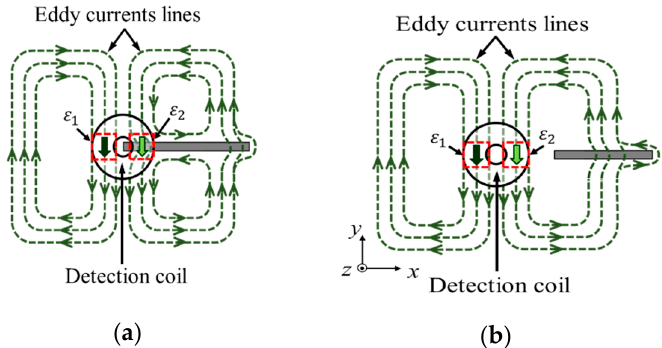
Figure 3. Butterfly probe under unbalanced conditions: ( a ) the edge of a flaw is located under the detection coil; ( b ) the flaw is located a short distance away from the detection coil.